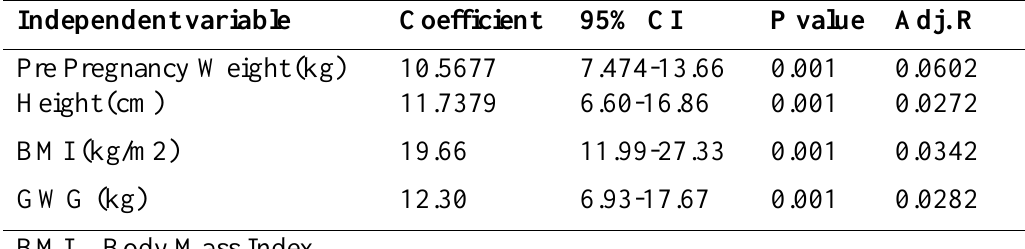
Table 04 - Simple linear regression analysis showing the effect of maternal